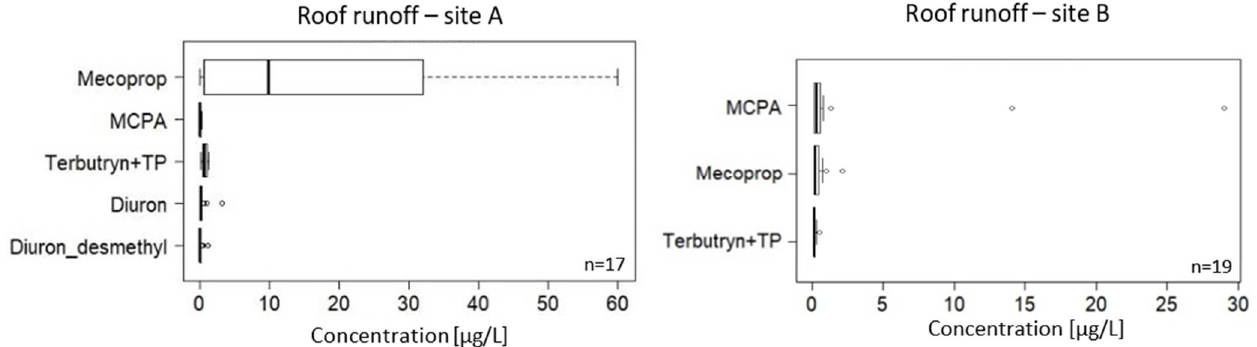
Figure 3. Concentration of organic trace pollutants in roof runoff at site A and